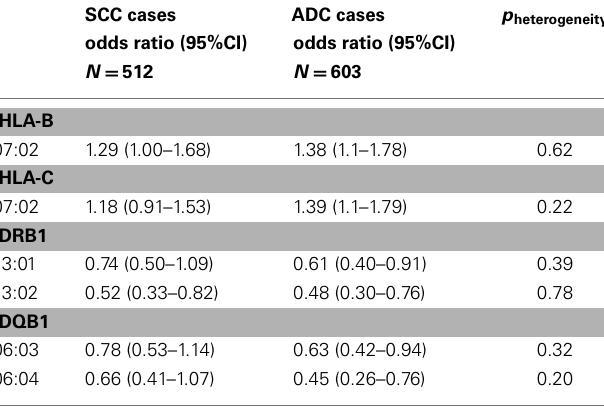
Table 2 |Association between HLA alleles and cervical adenocarcinoma (ADC) and squamous cell carcinoma (SCC), among Caucasians, PooledWestern and Eastern US cervical cancer studies